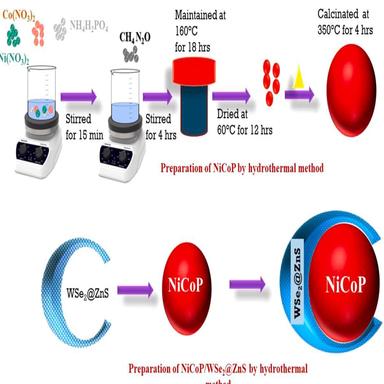
XRD pattern of NiCoP, NiCoP/WSe2 and NiCoP/WSe2@ZnS.